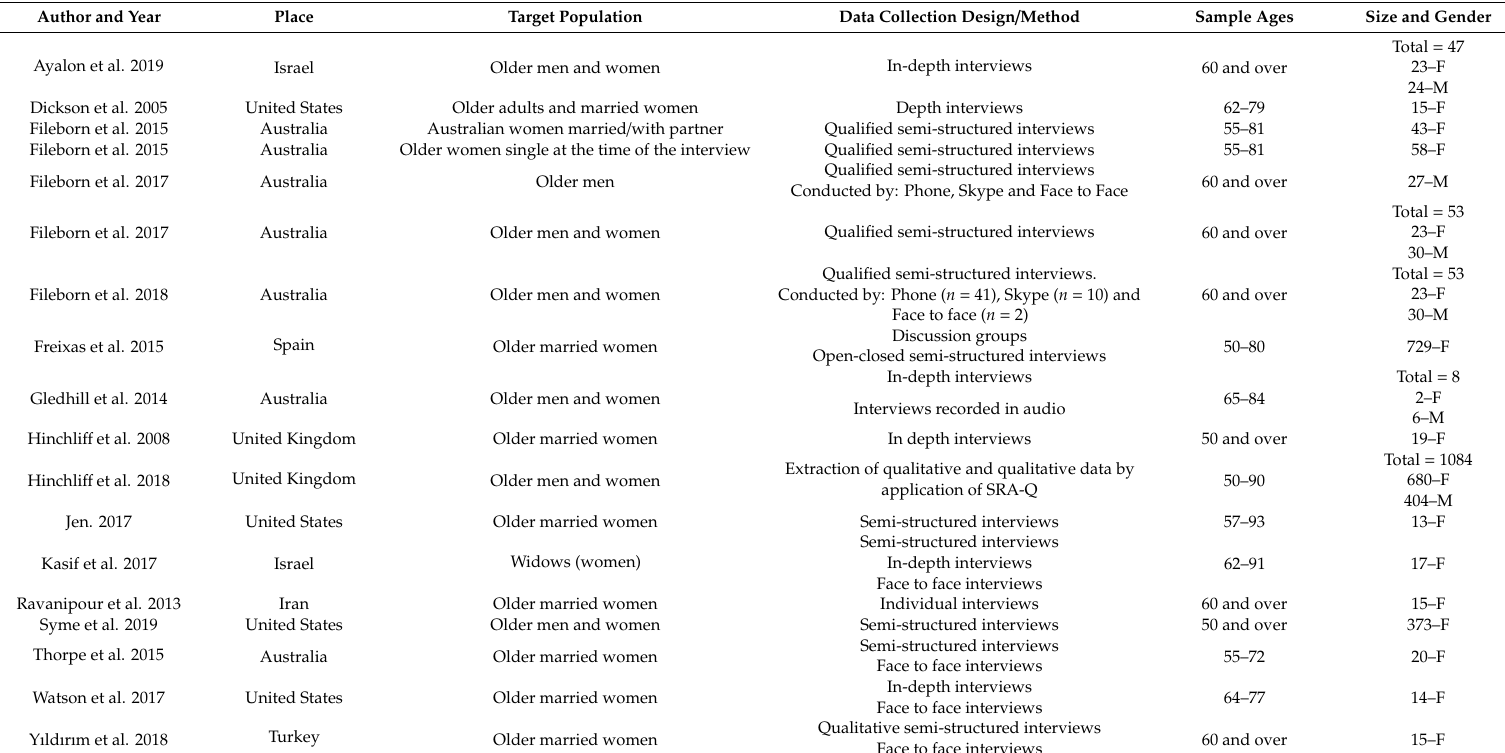
Table 3. Characteristics of the qualitative studies included in the